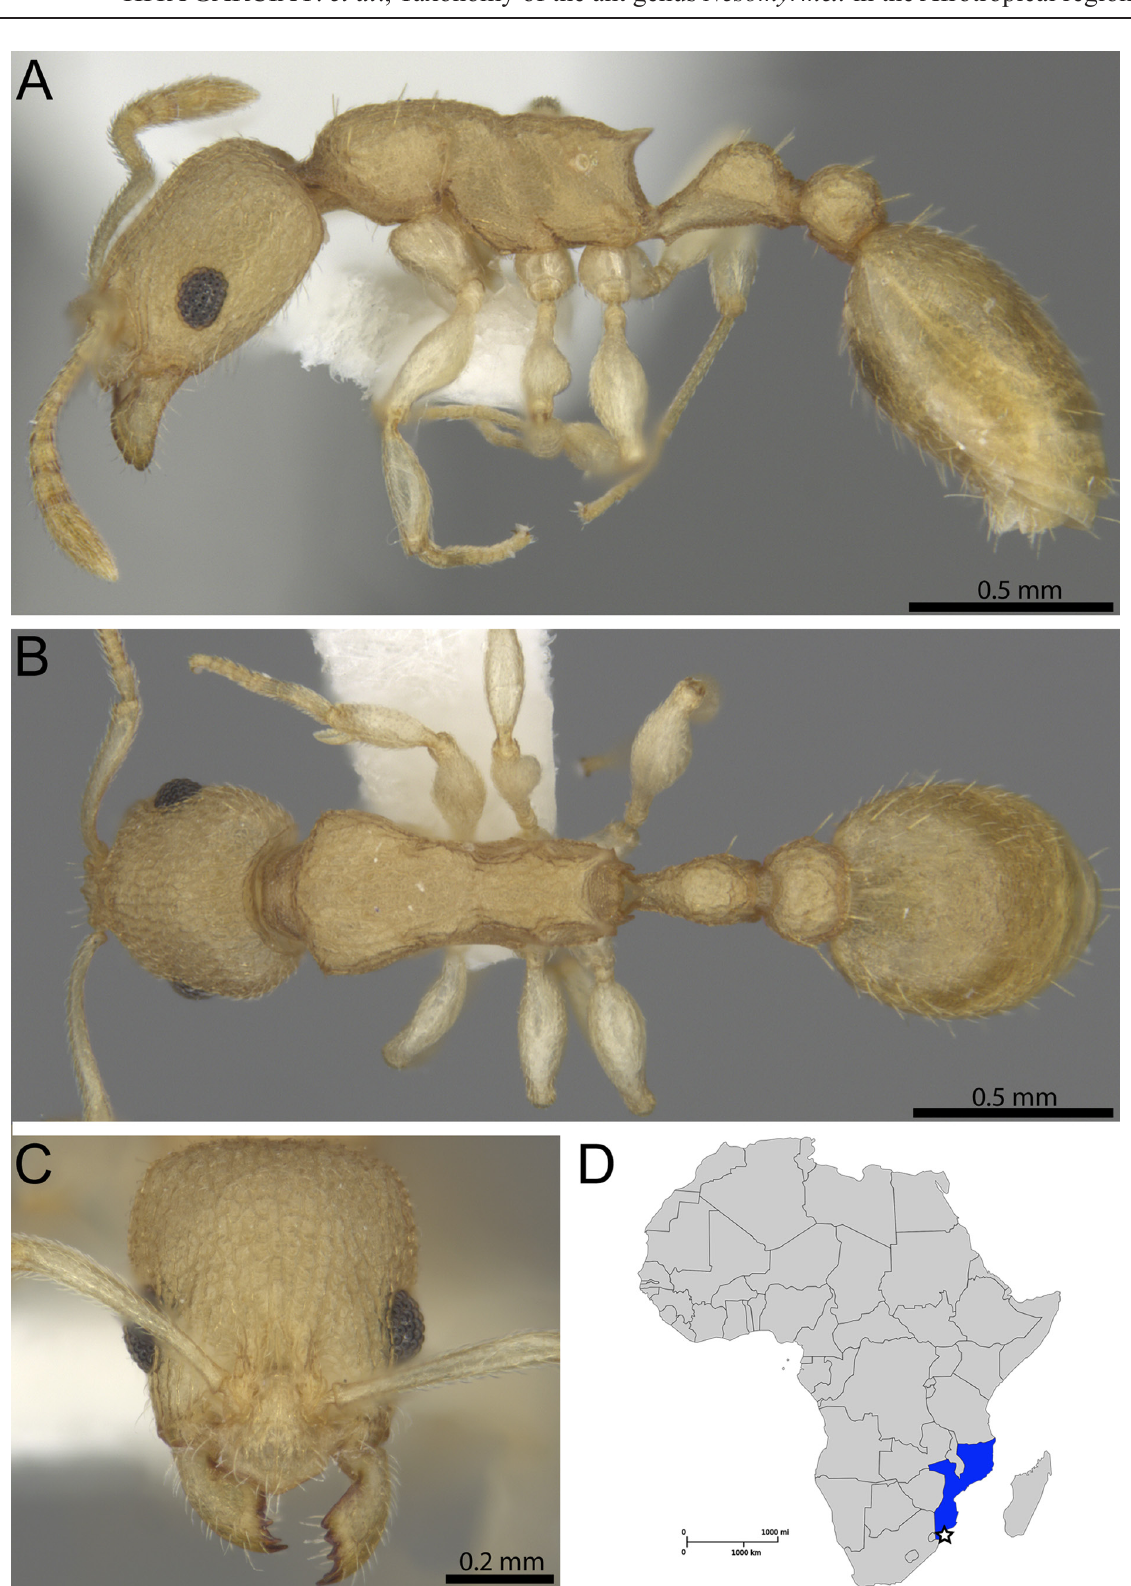
Fig. 18. Nesomyrmex inhaca sp. nov., holotype (MCZ-ENT00593557). A . Body in profile view. B . Body in dorsal view. C . Head in full-face view. D . Map of Africa and Madagascar showing currently known distribution and type locality (black and white